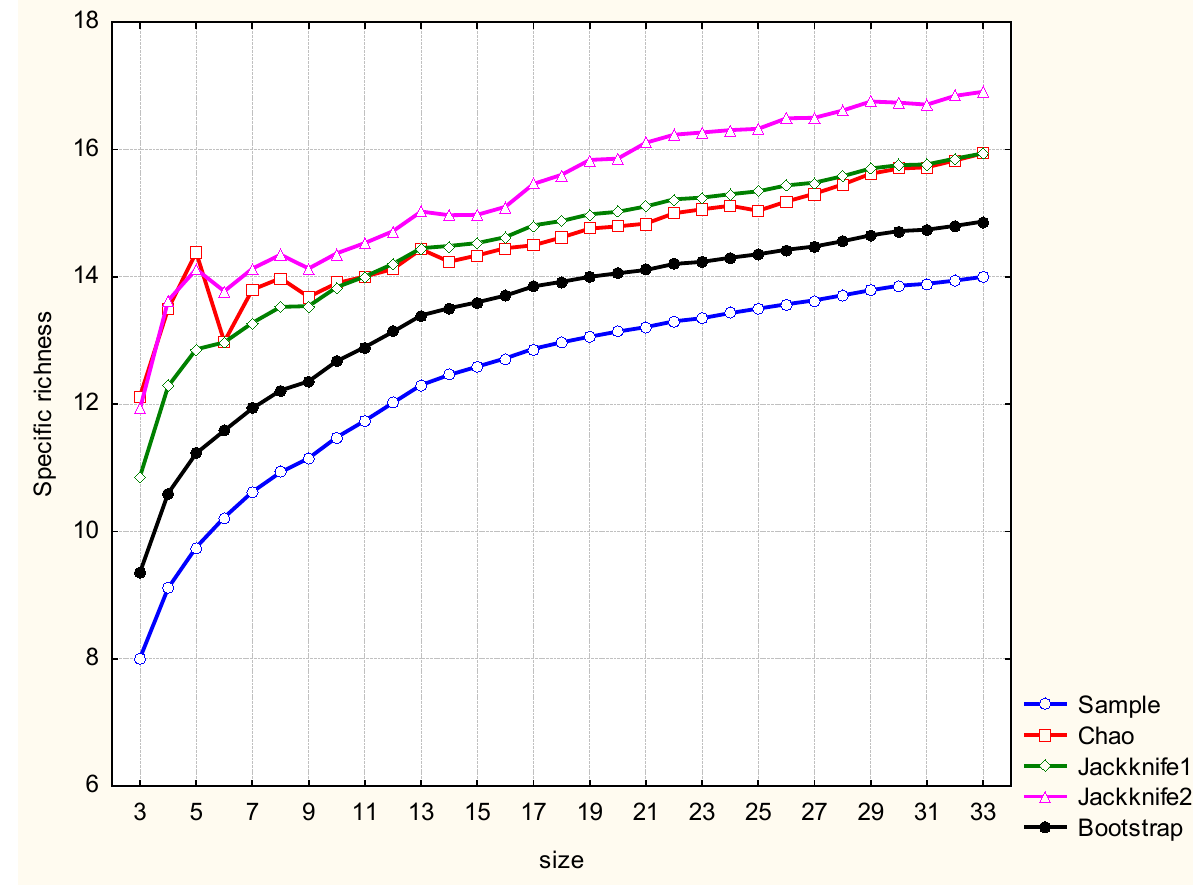
Fig 6 .Curves of accumulation of the species, estimators of the richness in Azeffoun.